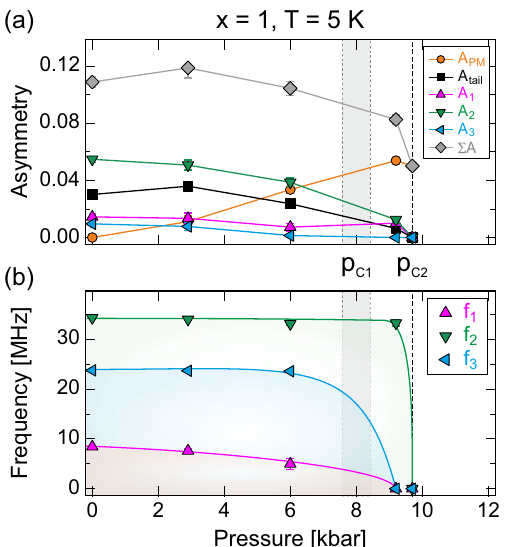
Figure 2. Pressure dependent fit parameters, collected at T = 5 K, of the x = 1 compound obtained through Eq. (1). For reference, (cid:31) A = (cid:31) A AF i + A tail + A PM has been computed and is included as well. The solid lines are guide to the eye while the vertical shaded area and dashed line indicate the critical pressures, p c1 ≈ 8 kbar and p ′ c2 ≈ 9.5